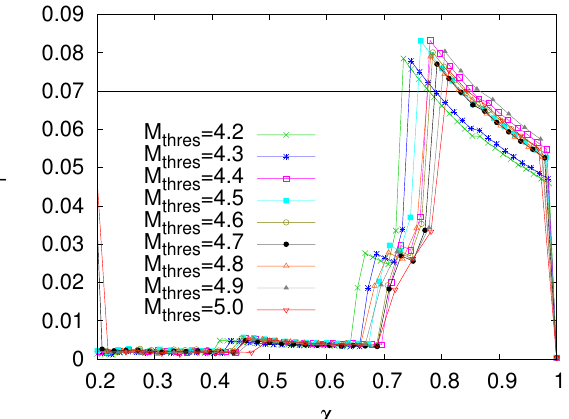
Figure 9. The evolution of the κ 1 values of seismicity in a similar fashion as in Figure 8B, but plotted versus natural time χ ( χ = 1 corresponds to the occurrence of the M 9 Tohoku EQ, while χ ≈ 0.2 to the M 7.3 foreshock on 9 March 2011). Taken from Ref. [64].